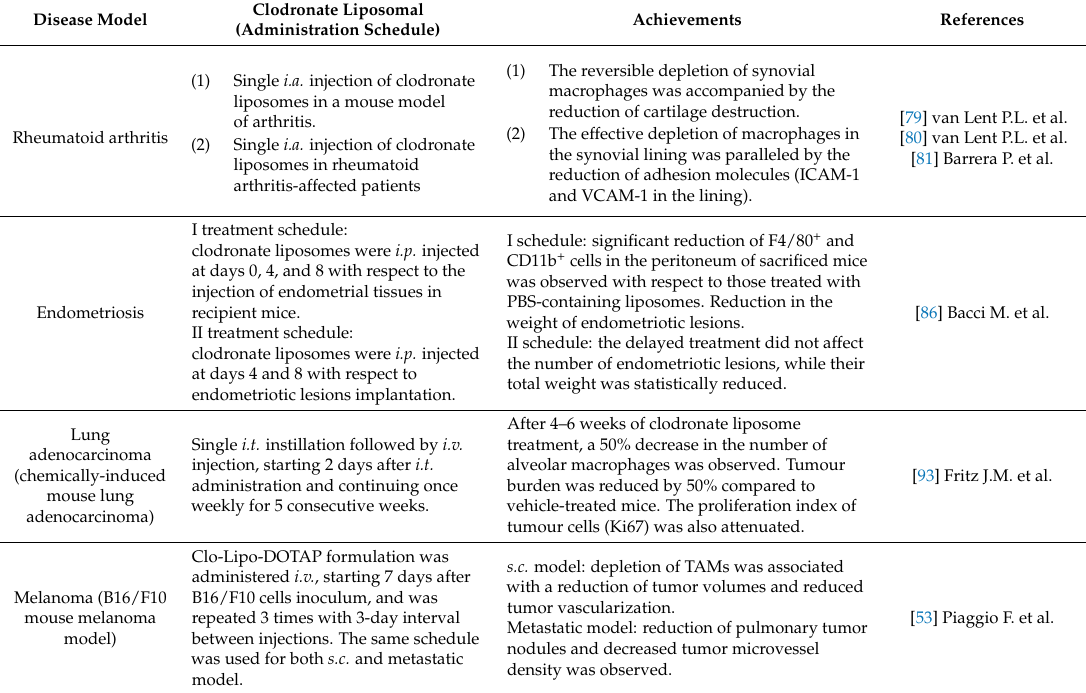
Table 2. Nanomedicine and macrophage functionality: macrophage depletion in disease